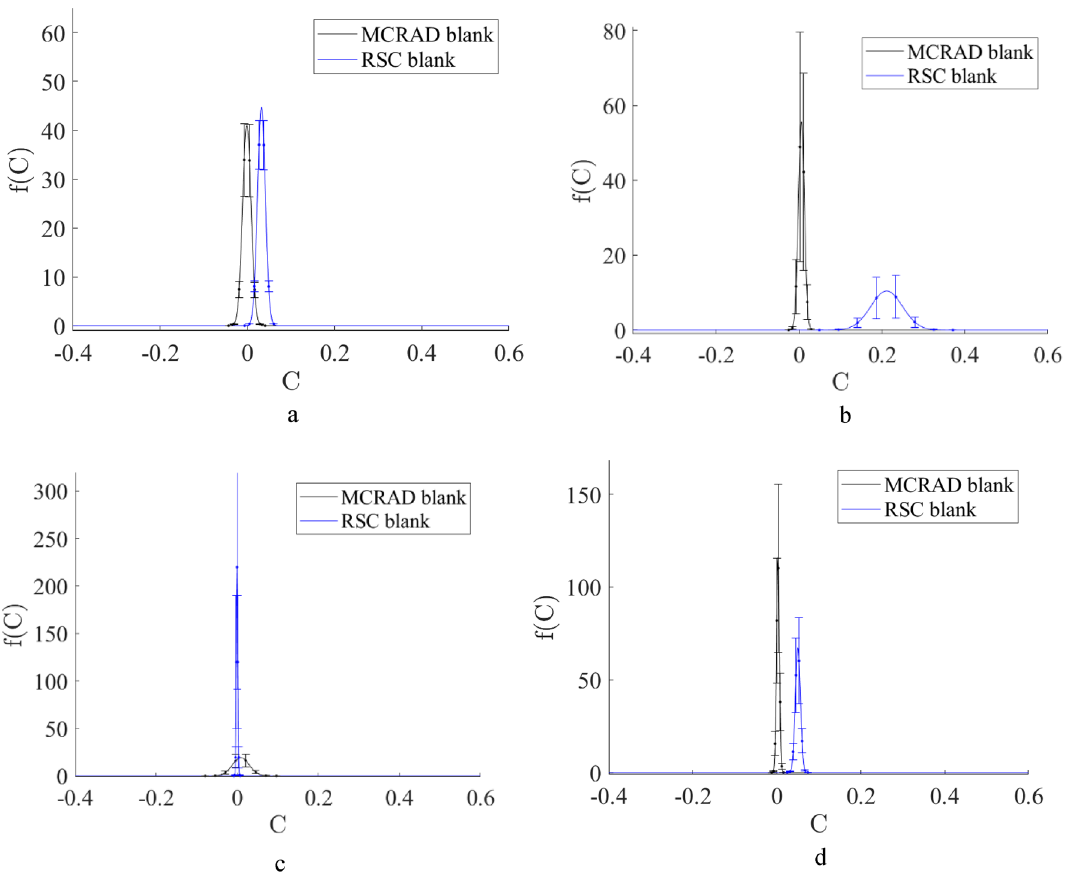
Figure 5. The blood volume fraction restored by MCRAD and RSC in experimental Raman spectra of pure blue polyester ( a ), denim ( b ), cotton fabric ( c ), and white polyester ( d )